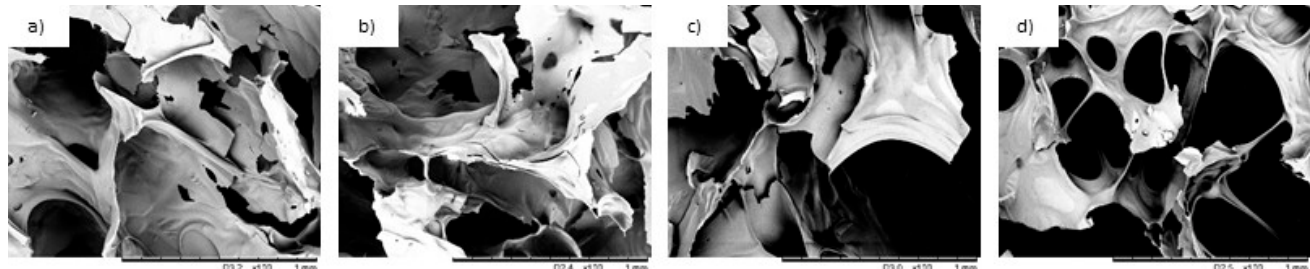
Figure 9. SEM images for the studied RPUF composites residues (after the cone calorimeter test)—( a ) Neat RPUF; ( b ) CF 0.1;